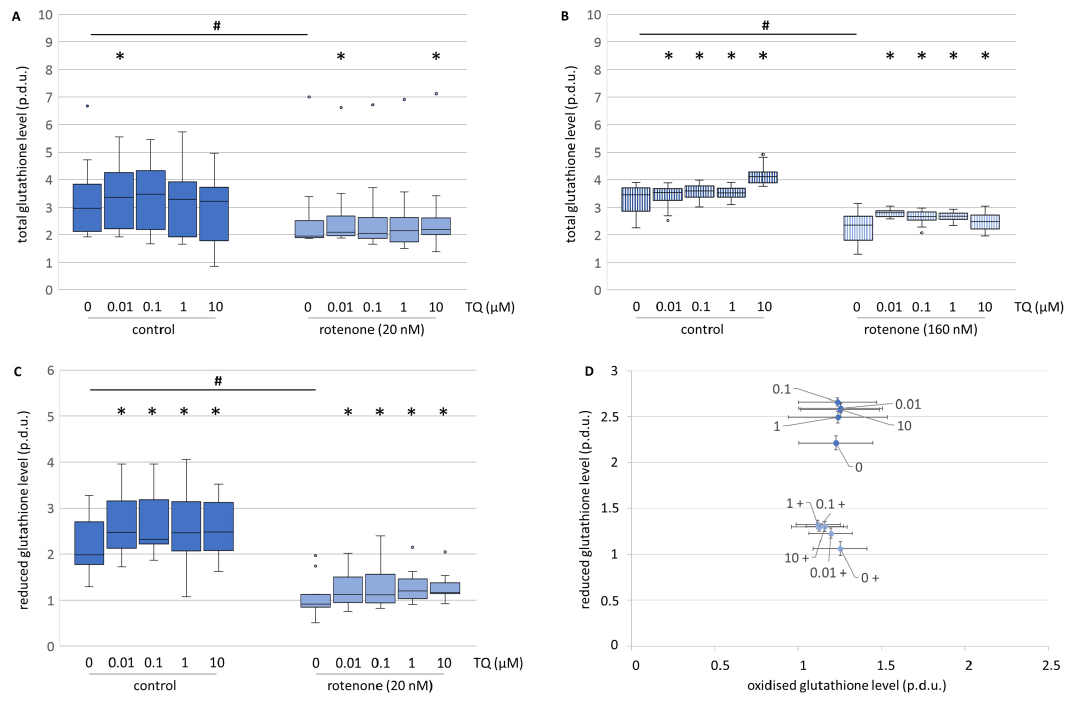
Figure 9. Effects of TQ on the total glutathione (GSSG + GSH) and reduced (GSH) levels in primary mesencephalic cultures ( A , C ) and total glutathione (GSSG + GSH) levels in the neuroblastoma cell line ( B ) and a comparison of reduced/oxidised glutathione ( D ) in the absence and presence of rotenone after 48 h treatment. The Data represent 14 ( A ), 4 ( B ), or 9 ( C ) independent experiments. Statistically significant differences between the TQ groups compared to the respective controls were determined using the Kruskal–Wallis (H) test followed by the χ 2 test (* p < 0.05). The Mann–Whitney (U) test was used to evaluate the effects of rotenone vs. the control (# p < 0.05). Exposure of the mesencephalic cell culture to rotenone decreased the total and the reduced glutathione levels significantly to 1.9 p.d.u. (Figure 9A) and 0.9 p.d.u. (Figure 9C),